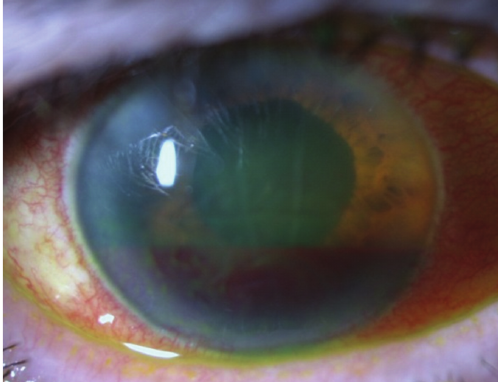
Figure 4: Biomicroscopy OD after 5 weeks—Descemet’s folds and hyphema without